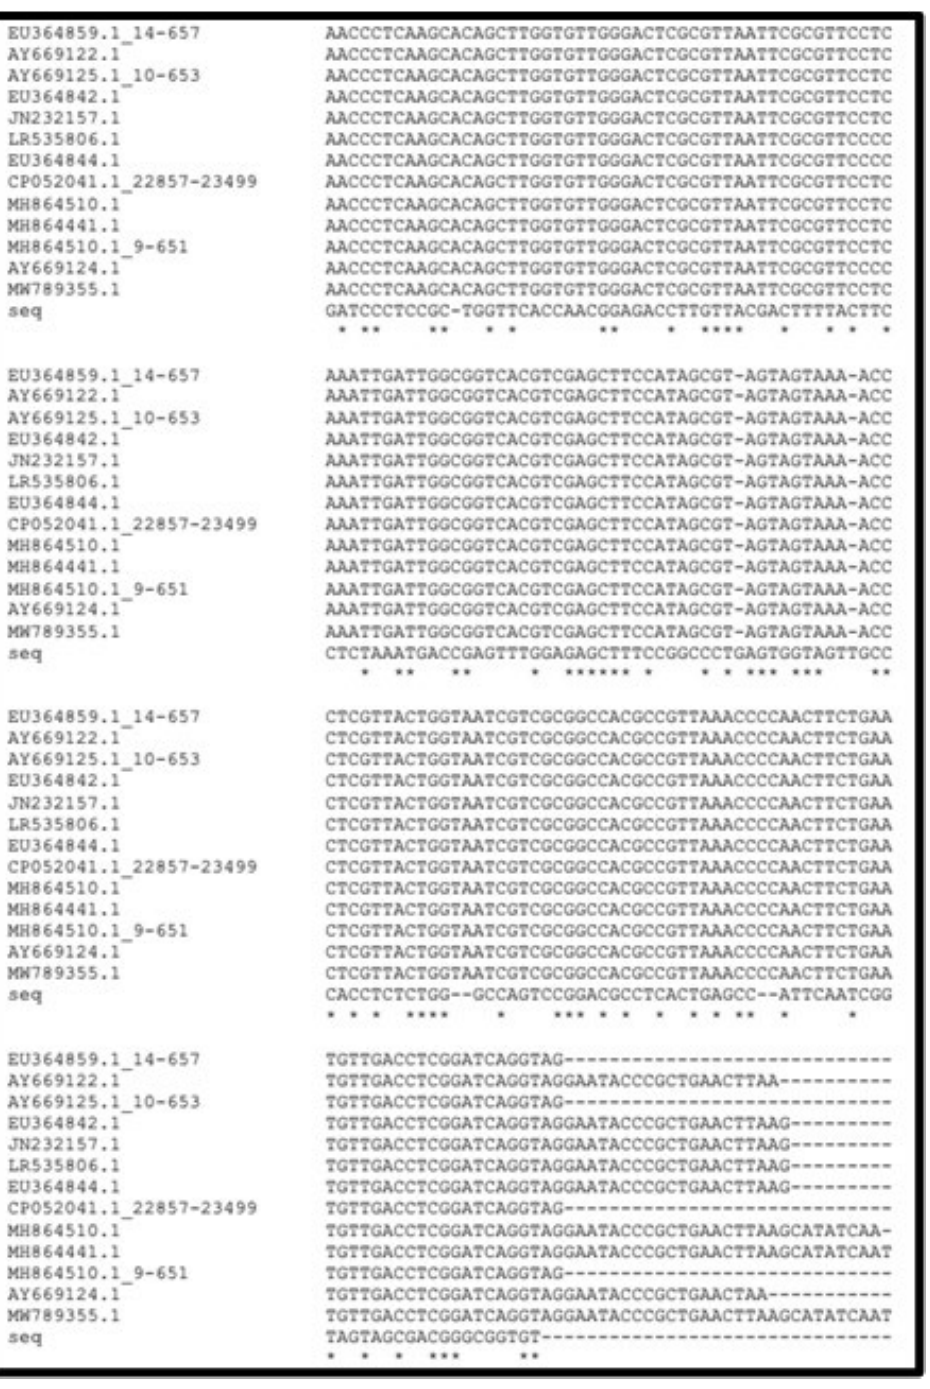
RNA gene with the internal transcribed spacer 2. The sequence was deposited in DNA Data Bank of Japan (DDBJ) with accession